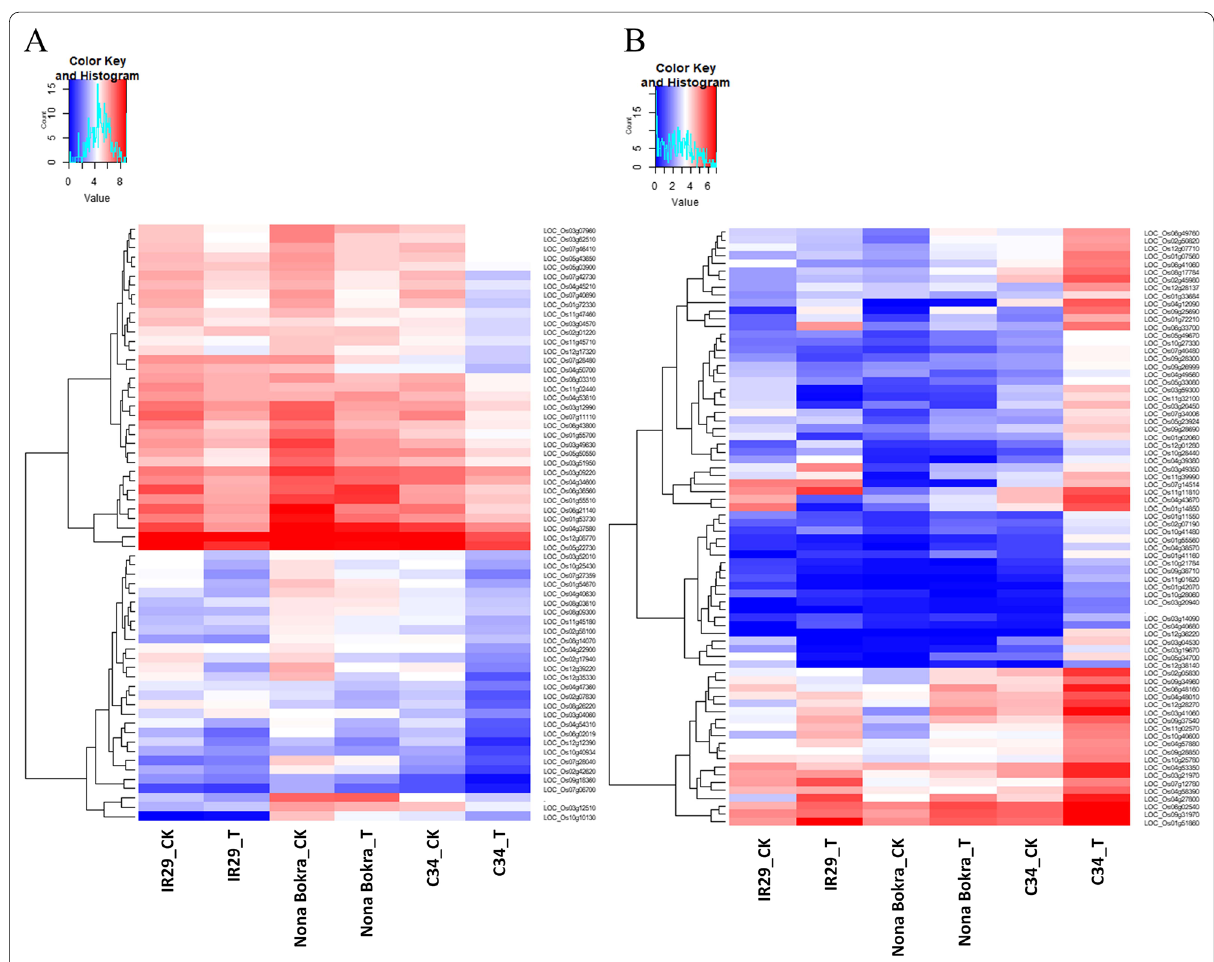
Fig. 4 DEGs regulated to more extents in ‘C34’ than that of ‘NB’. A . DEGs suppressed more in ‘C34’ than in ‘NB’. B . DEGs up-regulated more in ‘C34’ than in